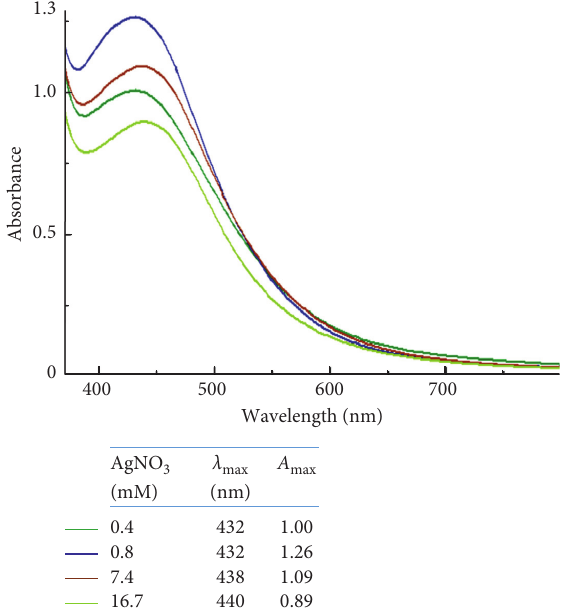
Figure 5: UV-vis spectra of AgNO + concentrations after 30 min of sunlight irradiation. Inset table: maximum 3 /PPE with different Ag absorbance ( A max ) and λ max of these